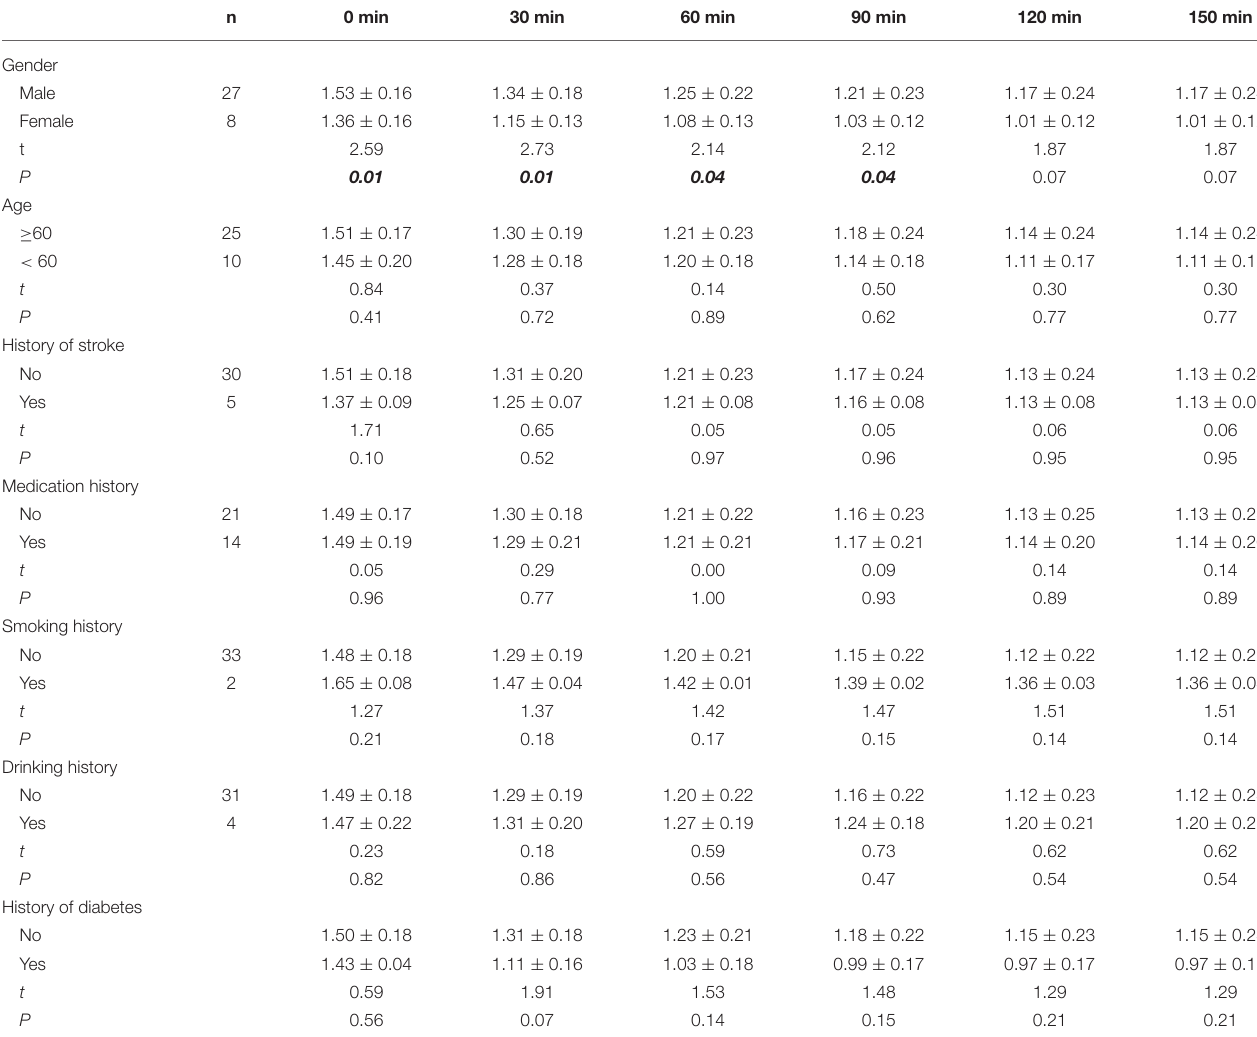
TABLE 1 | The relationship between blood clot of standard group and clinical data. n 0 min 30 min